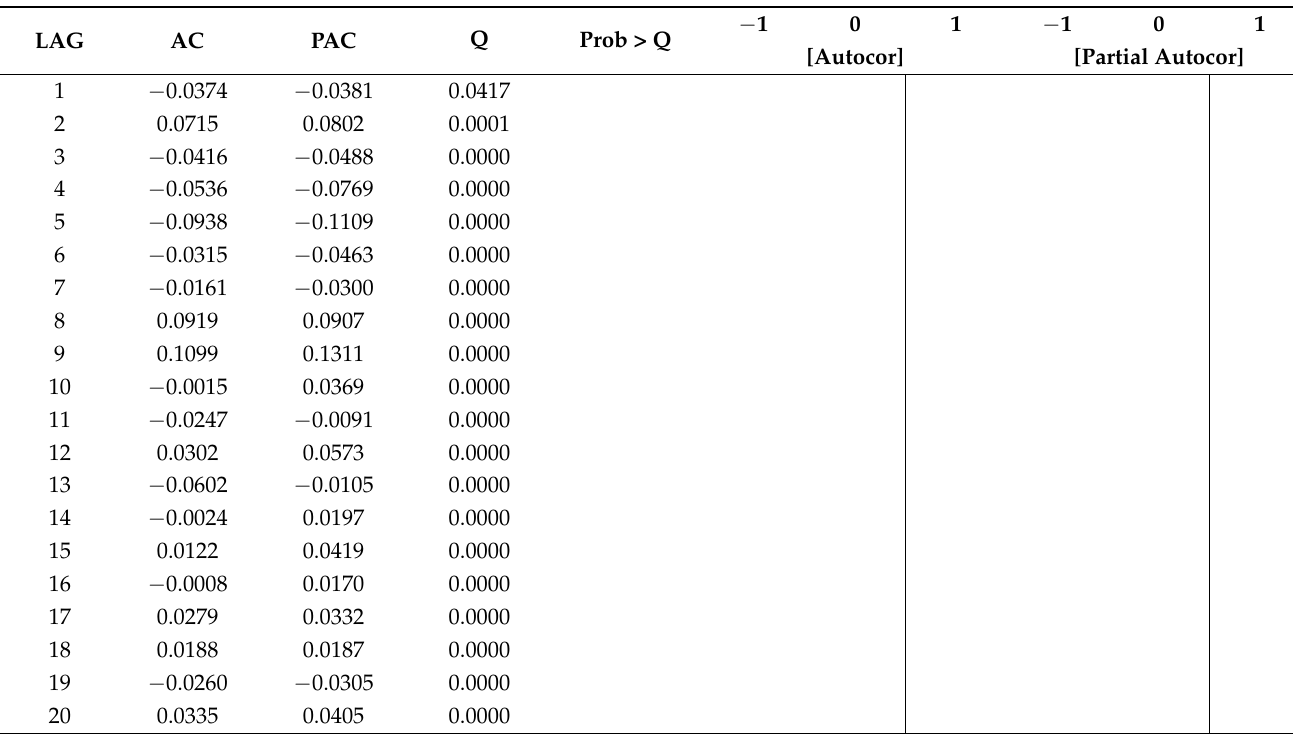
Table A3. Autocorrelation